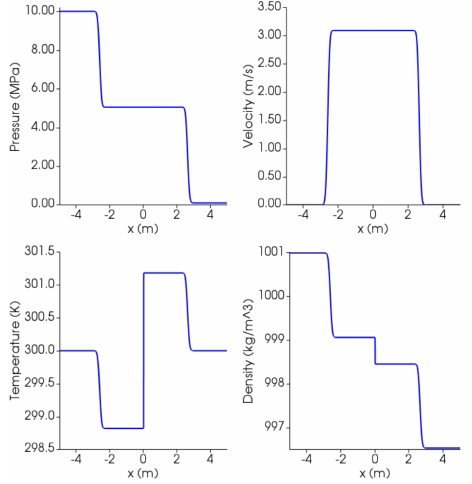
Figure C2. Results at time t = 0 . 00164s for single-phase shock tube with liquid water using SPWAT EOS. At time 0, the interface dividing the high-pressure (left, l) from low-pressure (right, r) zone is placed at 0. Initial conditions: P l = 10 MPa , P r = 0 . 1 MPa ; T l = T r = 300K; gas volume fraction α l = α r = 0; U l = U r = 0. Isobaric heat capacity is C P = 4195Jkg − 1 K − 1 (https://webbook. nist.gov/, last access: 27 April 2022).